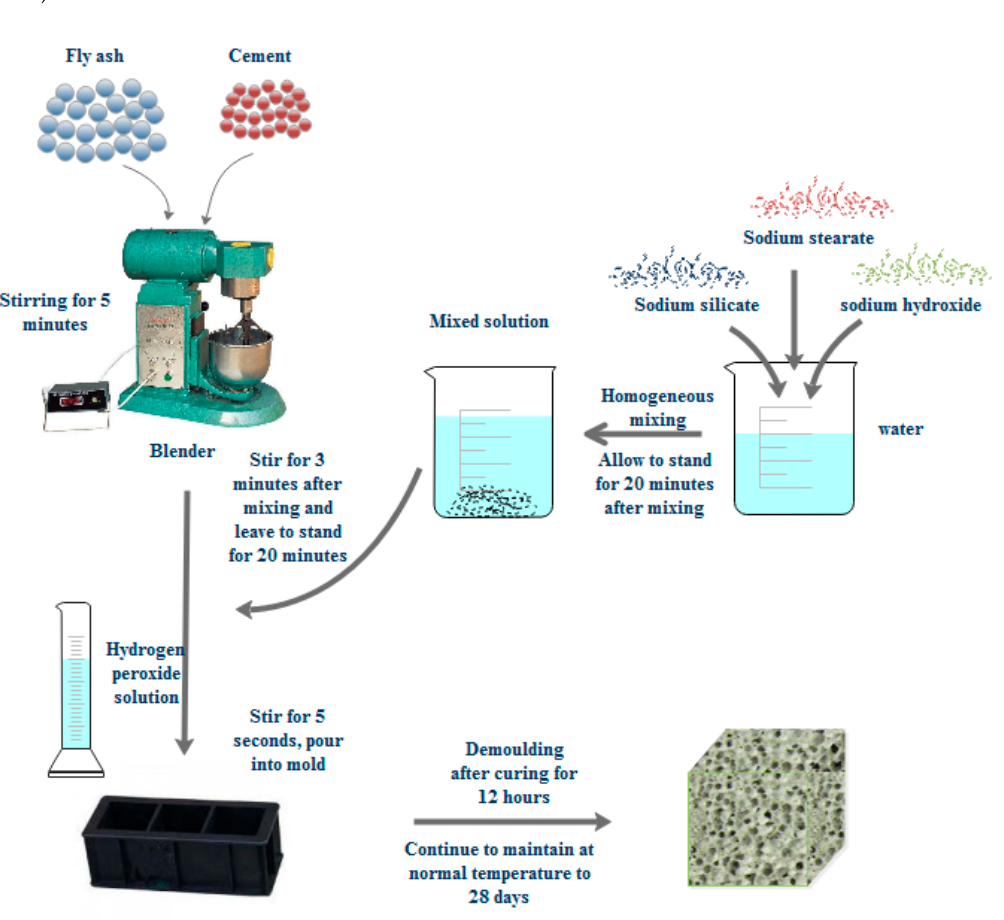
Figure 1. Manufacturing process of fly ‐ ash ‐ based foamed geopolymer.